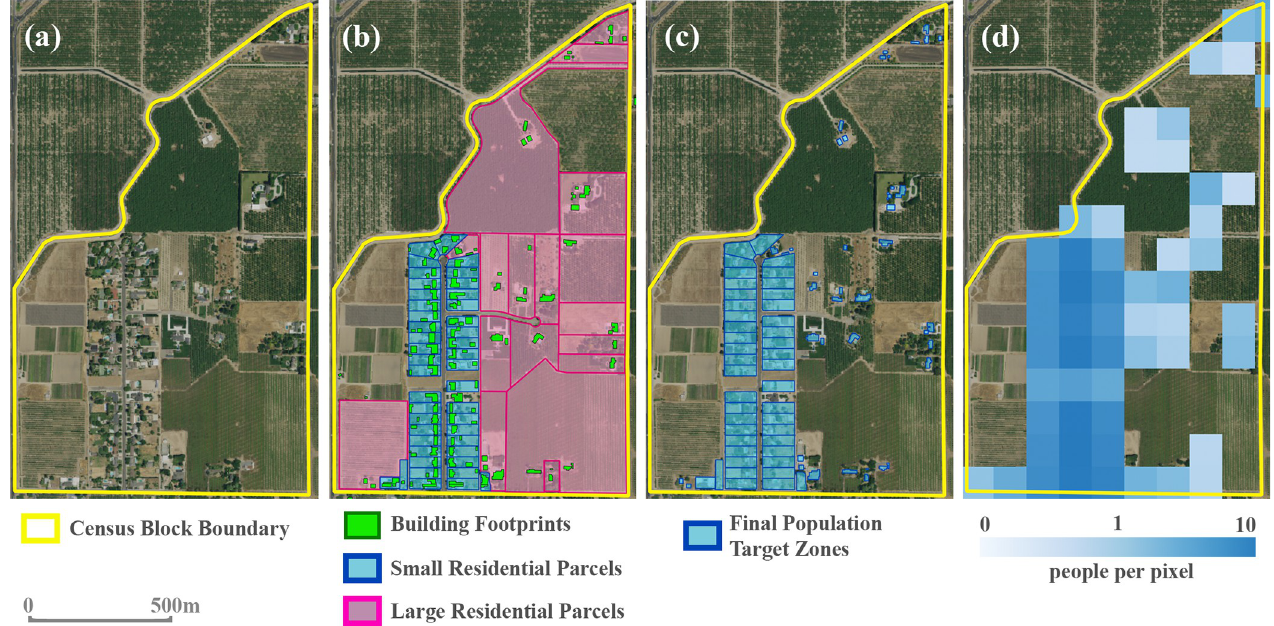
Fig 2. CA-POP’s dasymetric mapping method applied to a single census block. Example shown is just north of Modesto, CA. Panel (a) shows the block boundary; (b) shows the ancillary residential parcel and building footprint boundaries; (c) shows the polygon boundaries used as the final target zones to assign the block’s population values, retaining the small residential parcel polygons and building footprint polygons within large residential parcels; (d) shows the 100m-resolution grid produced from population apportioned to the final target zones. (Satellite base imagery source: USGS (NAIP) from The National Map).